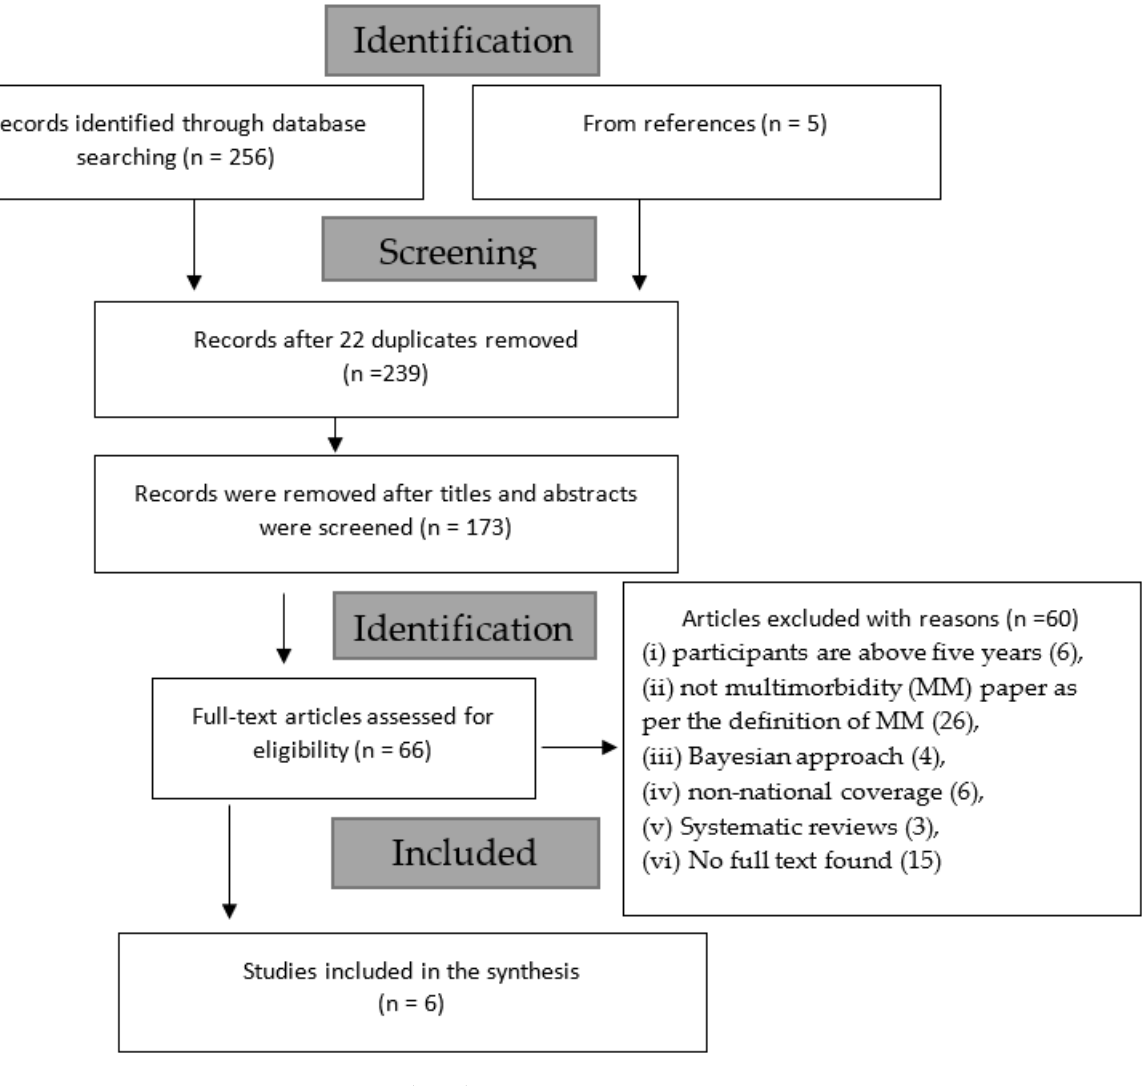
Figure 1. PRISMA Flow chart.